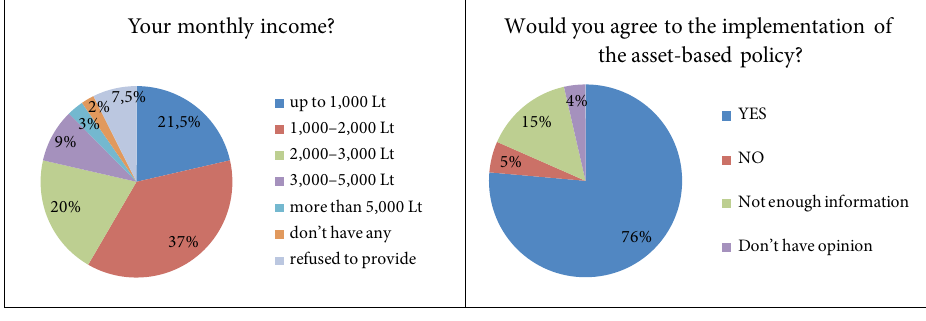
Fig. 7. Respondents’ attitude towards the implementation of the asset-based policy (authorial computation, according to the survey data)